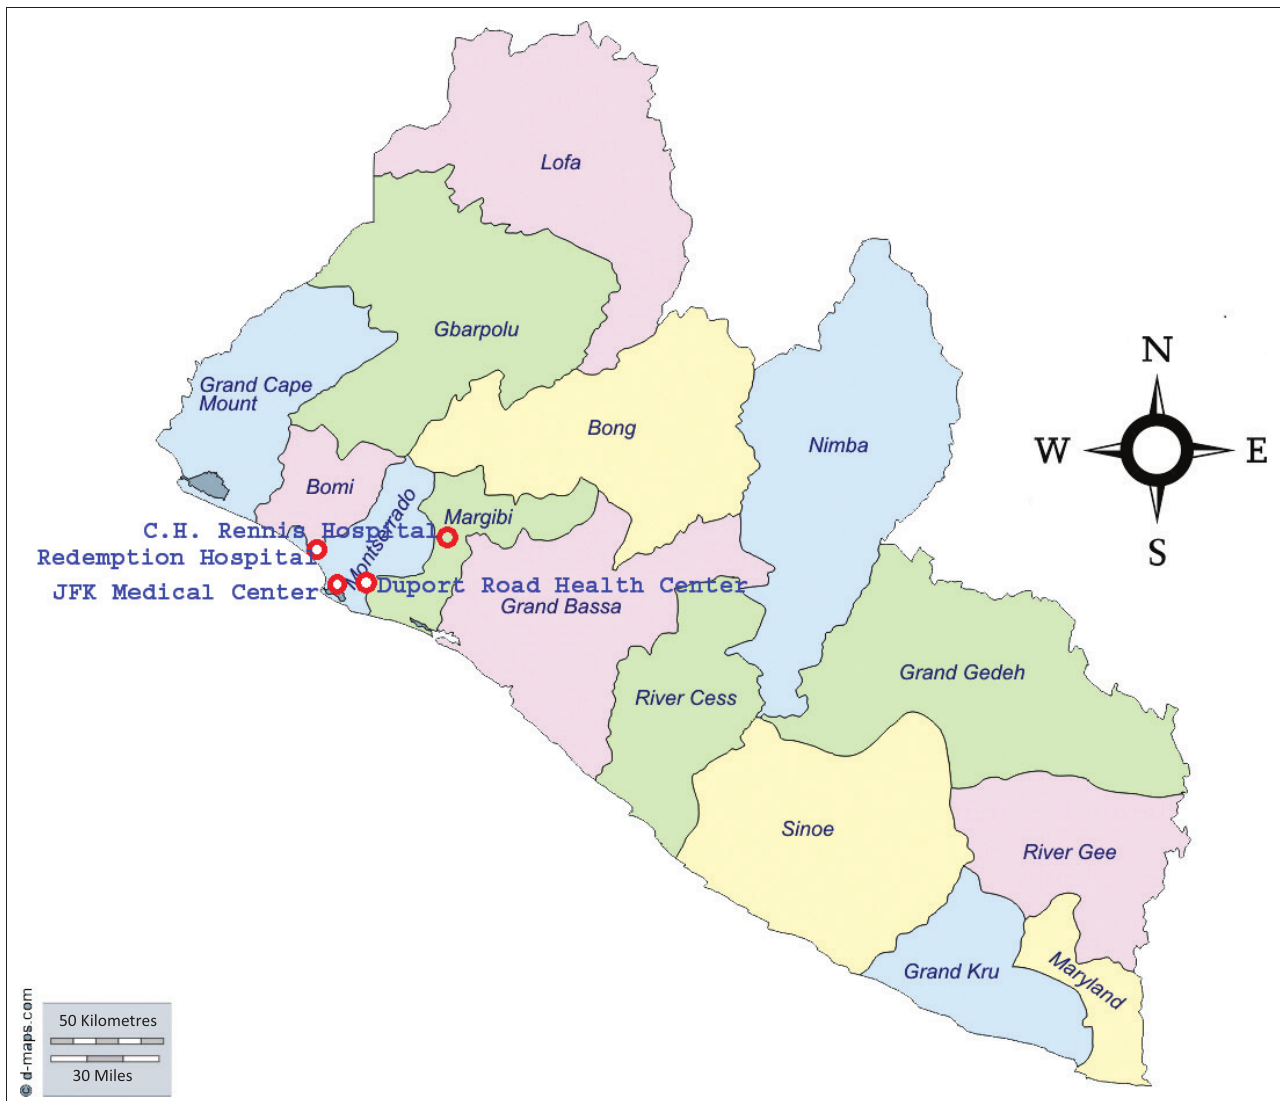
FIGURE 1: Map of Liberia and location of study